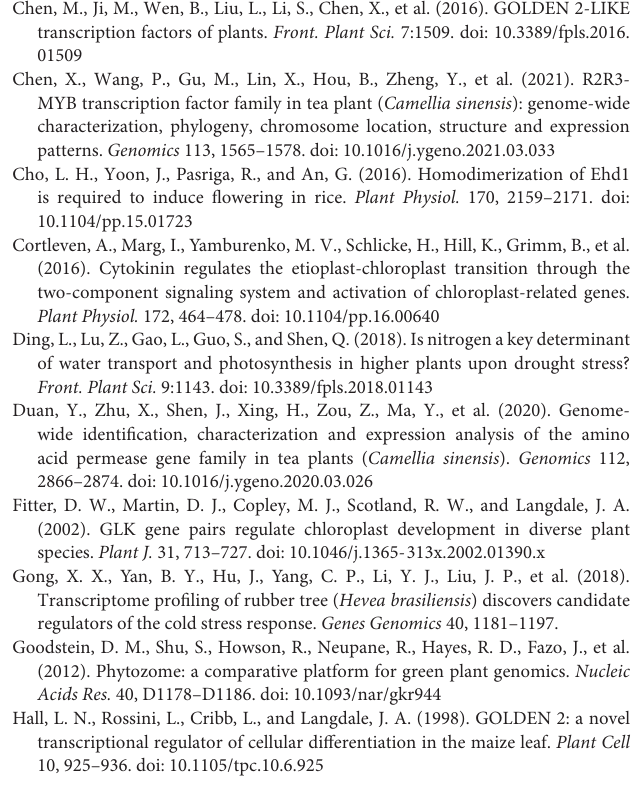
Supplementary Figure 1 | Phylogenetic tree of GARP proteins from 19 species constructed by the ML method. Supplementary Figure 2 | Overview of multiple sequence alignment of 69 CsGARP proteins. The sequence alignment of 69 CsGARPs was conducted using ClustalX, and visual analysis was performed through Jalview. Supplementary Figure 3 | Chromosomal locations of 69 CsGARP